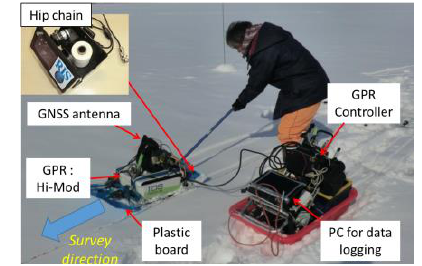
Figure 6. The GPR system used in the experiment.